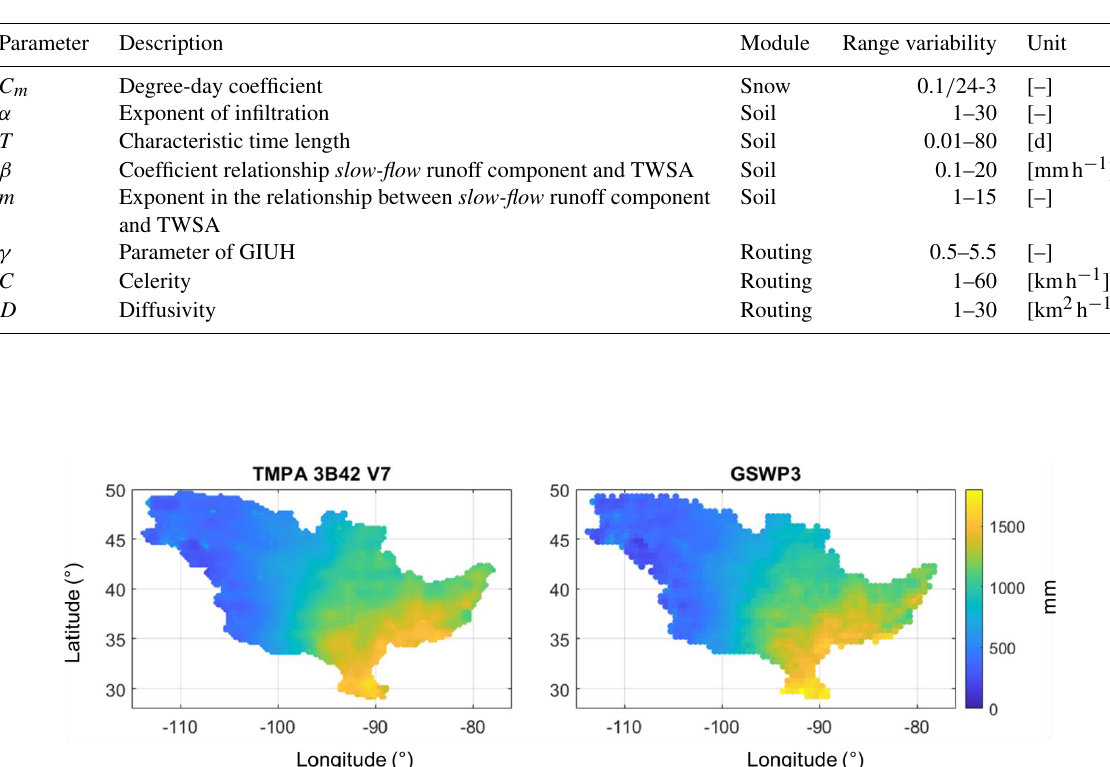
Table A1. Description of STREAM parameters, belonging module, variability range, and unit.